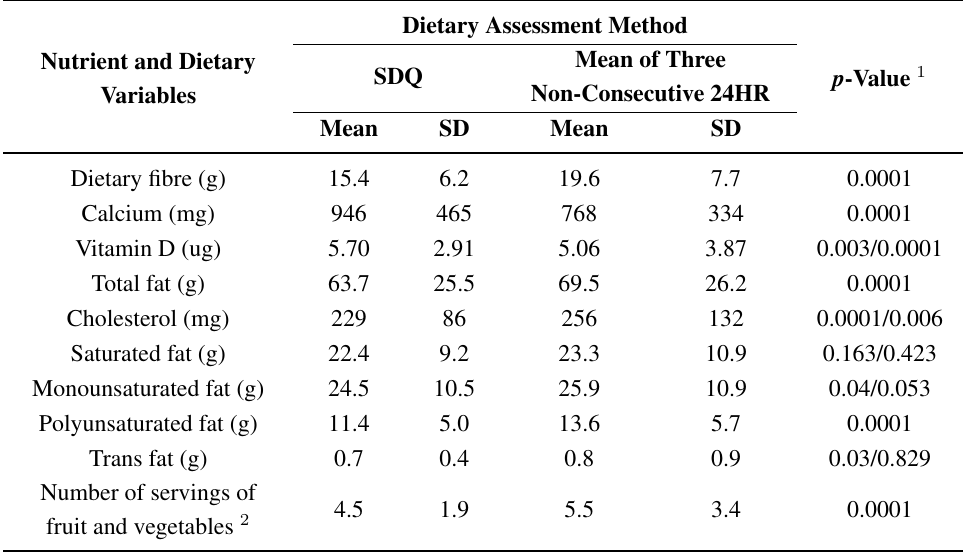
Table 2. Estimated intakes of nutrients of interest from SDQ and mean of three non-consecutive 24HR, SDQ validation study ( n = 396).